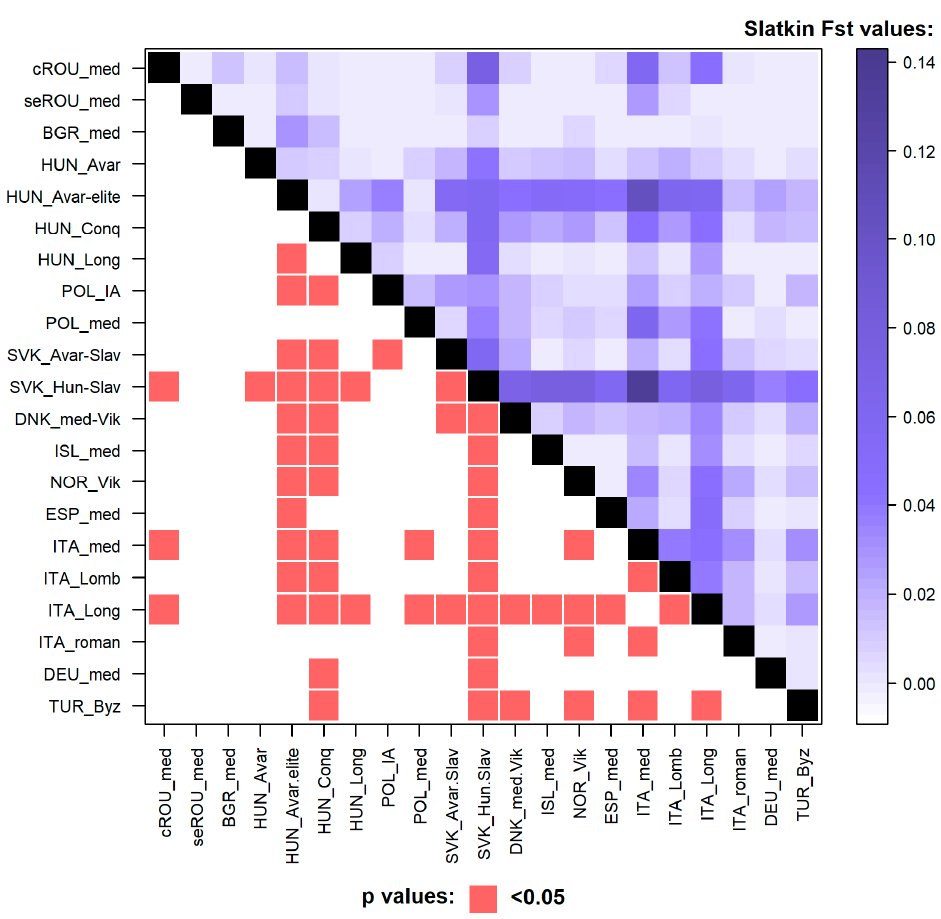
Figure 3. Levelplot of the linearized Slatkin population differentiation (Fst) values and significant p -values. Lower left corner: significant p -values (<0.05) are indicated in red. Upper right corner: larger Slatkin Fst values indicating greater genetic distances are marked by dark blue shades. The exact Fst and p -values are given in Table S5.